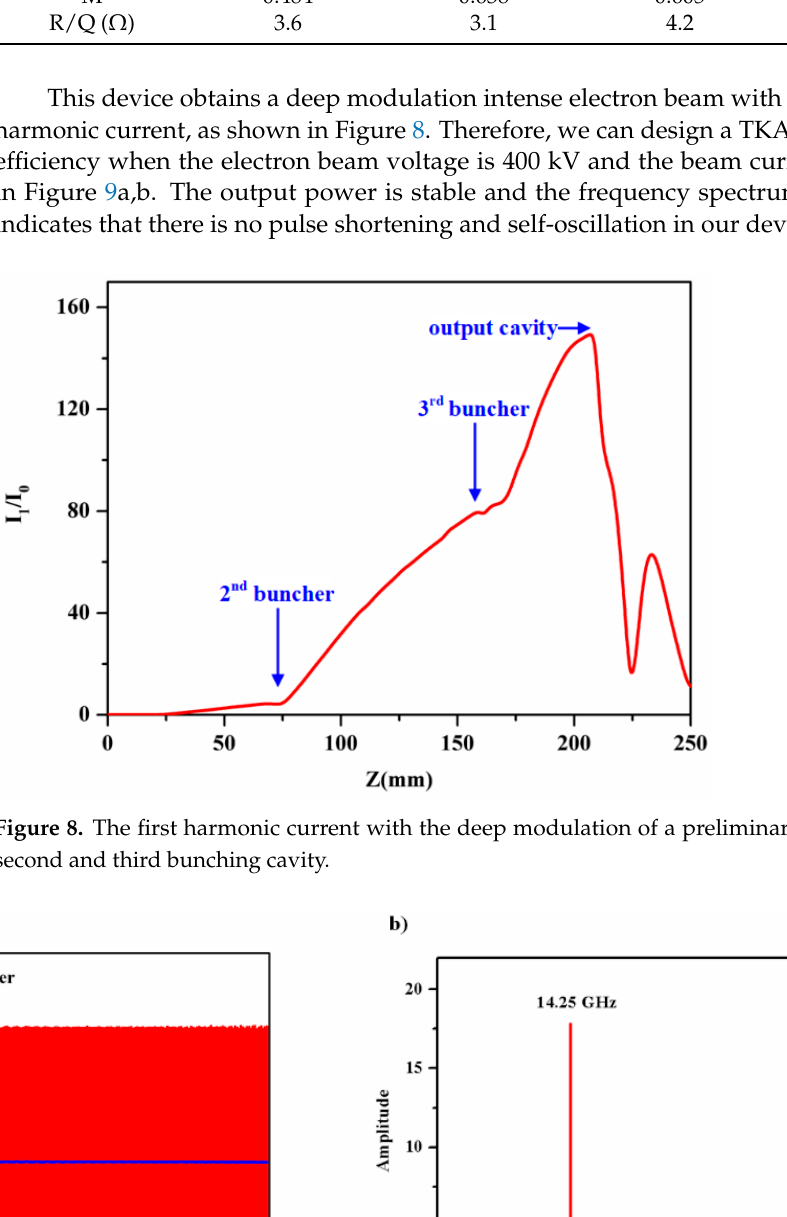
Table 1. Parameters of the multiple cavities RKA.